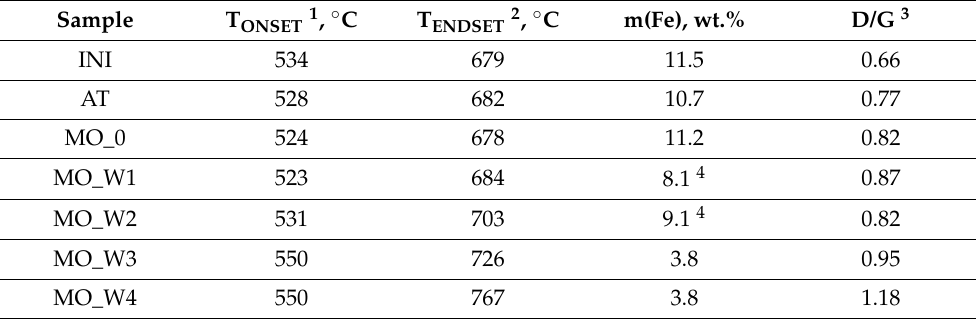
Figure 2. SEM images of initial CNTs synthesis product at 15,000 ( a ) and 100,000 ( b ) magnifications. Thermogravimetry and Raman spectroscopy results of initial and acid treated samples are presented in Table 2. Table 2. Thermogravimetry and Raman spectroscopy results of initial, acid treated samples and samples after mild oxidation with subsequent acid treatments.